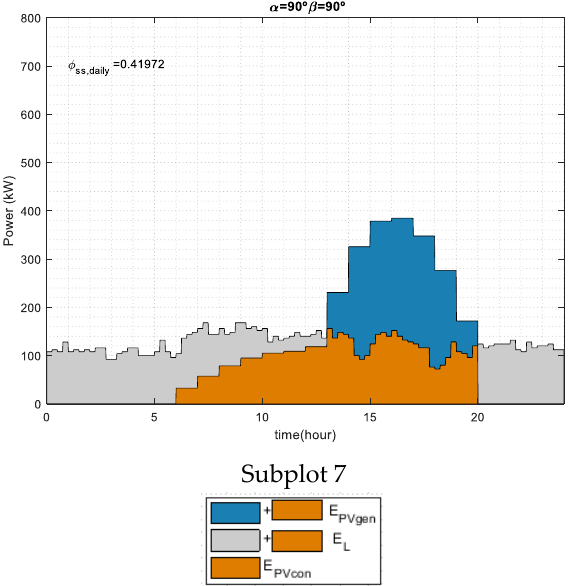
Figure 5. Daily photovoltaic generation and load consumption of olive mill in Ja é n (South of Spain). Load data correspond to 3 June 2018 and irradiance data correspond to 3 June TMY. E PV,con is represented by the orange area while E PV,gen is given by blue and orange area and E L is represented by grey and orange areas. P 0 is 900 kW p and the recording interval is 15 min for load profile and 60 min for photovoltaic generator profile. Subplot 1: α = 0 ◦ and β = 0 ◦ , Subplot 2: α = 0 ◦ and β = 45 ◦ , Subplot 3: α = 0 ◦ and β = 90 ◦ , Subplot 4: α = − 90 ◦ and β = 45 ◦ , Subplot 5: α = − 90 ◦ and β = 90 ◦ , Subplot 6: α = 90 ◦ and β = 45 ◦ and Subplot 7: α = 90 ◦ and β = 90 ◦ .